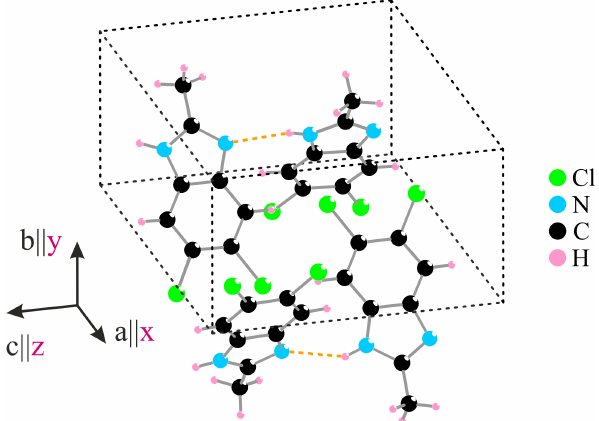
Figure 20. Crystal structure of DCMBI (the .cif files taken from the CCDC database can be found in the Supplementary